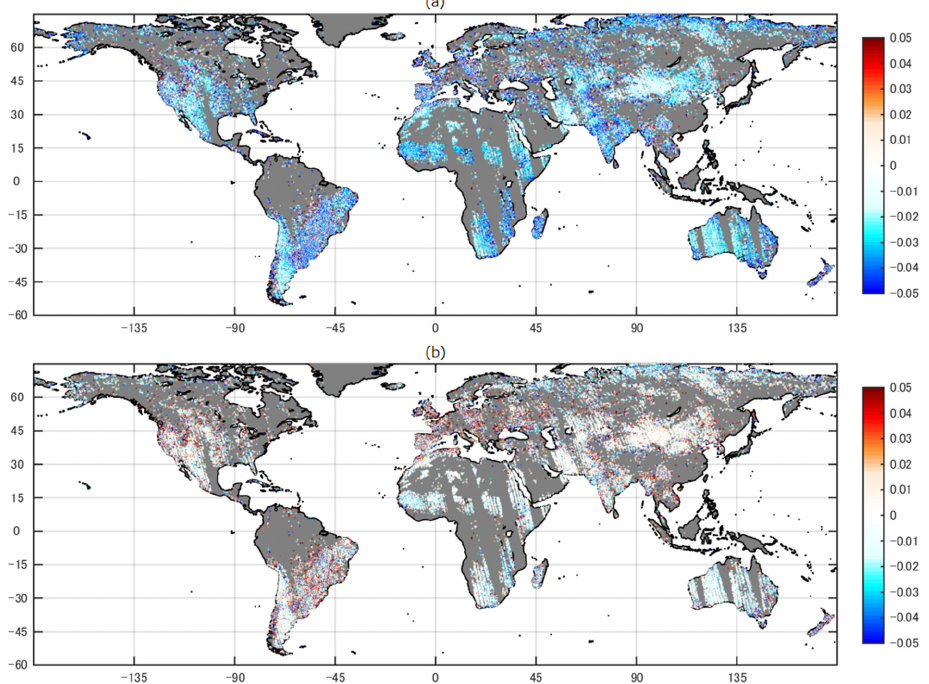
Figure 4. ( a ) Spatial distribution of MODIS EVI minus VIIRS EVI ( δ 1 ) over geographic coordinate for the calibration; ( b ) Spatial distribution of MODIS EVI minus MODIS-compatible EVI ( δ (cid:2870)∗ ).